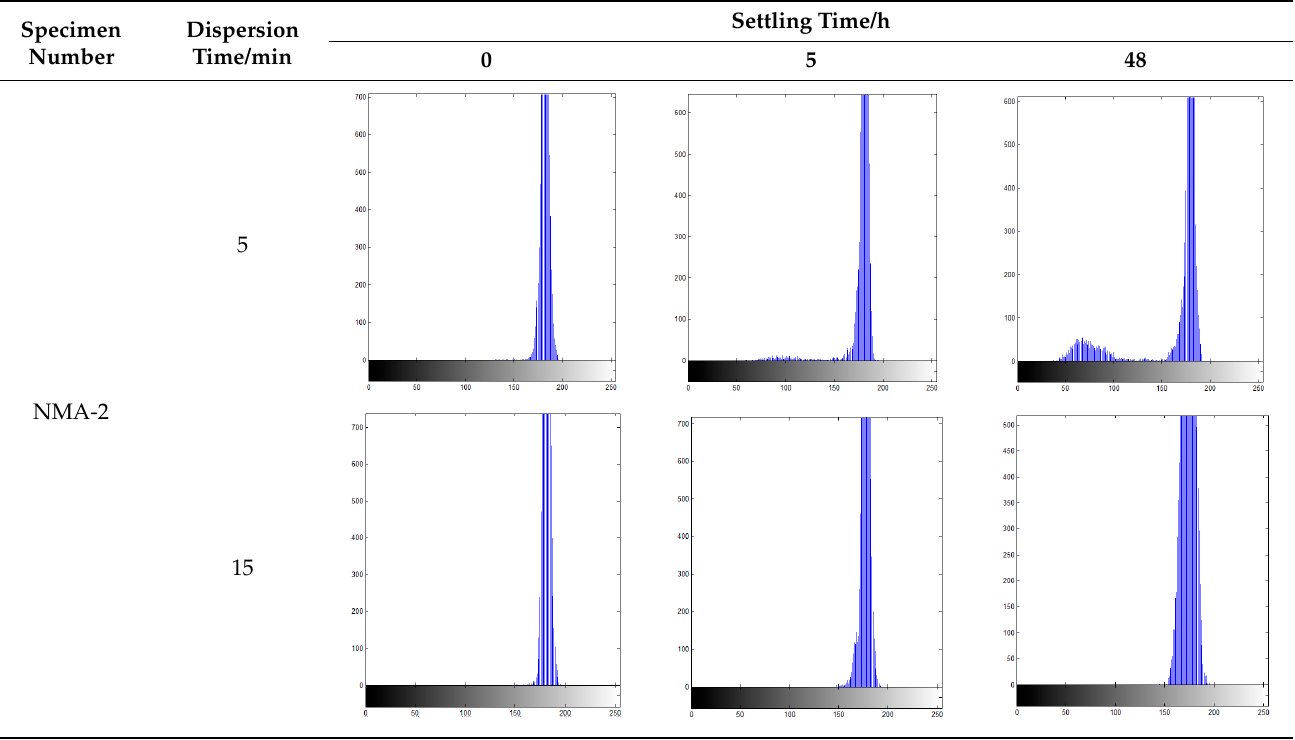
Table 5. The gray histogram of the nanoclay suspension.